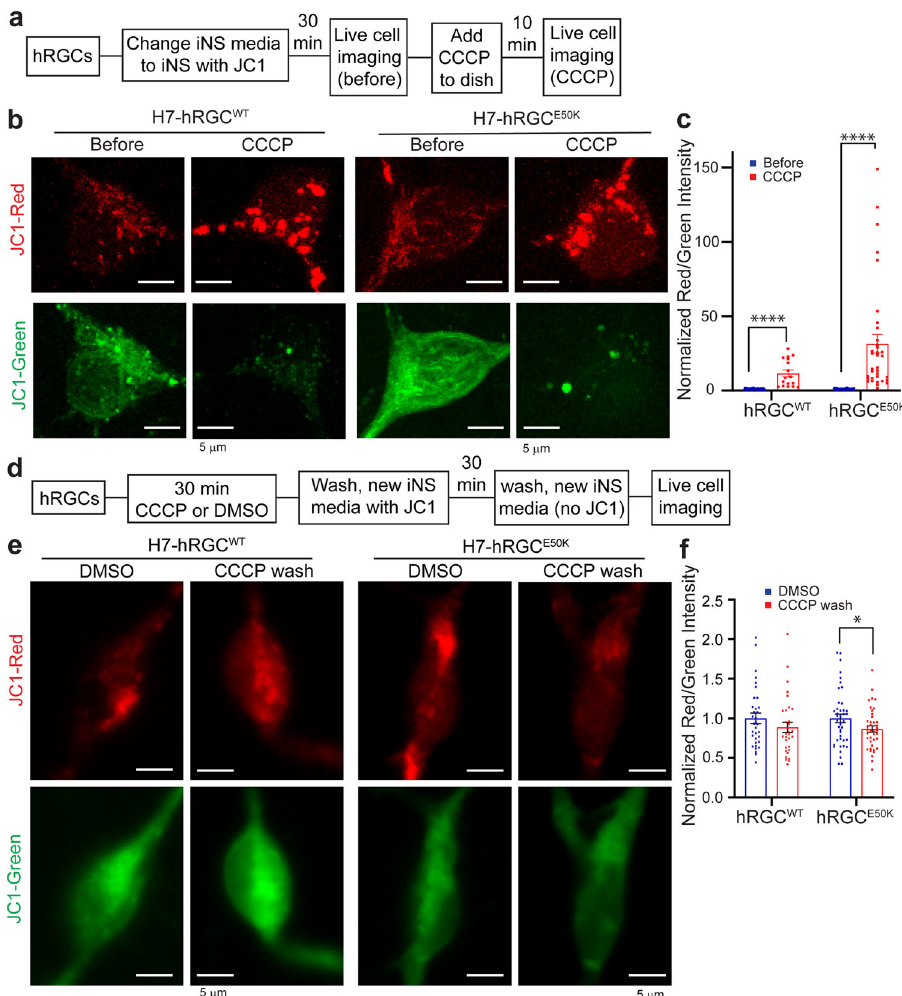
Fig. 2 Under acute damage hRGCs possess ef fi cient mitochondrial turnover mechanisms. a Schematic of JC1 experiment to monitor mitochondrial degradation and biogenesis under CCCP stress. b Representative confocal images of JC1 labeled mitochondria in hRGCs before and after 10 min CCCP (10 μ M) treatment. JC1 dye was added 30 min before CCCP and was present during treatments. Scale bars are 5 μ m. c Quanti fi cation of the red-to-green fl uorescence intensity ratios from the sum projections of confocal z-stacks, normalized to the corresponding before treatment values. n = 17-42 hRGCs. d Schematic of JC1 experimental design to study restoration of mitochondrial homeostasis after CCCP washout. e Representative confocal images of JC1 labeled mitochondria in hRGCs treated with DMSO or CCCP (10 μ M) for 30 min, washed, labeled with JC1 dye, washed again, and then imaged without JC1 dye. f Quanti fi cation of the red-to-green fl uorescence intensity ratios from sum projections, normalized to respective DMSO control. n = 32-43 hRGCs. ٭ p -value < 0.05, ٭٭ p -value < 0.01, ٭٭٭٭ p -value < 0.0001. Unpaired student ’ s t- test between independent datasets. Error bars are